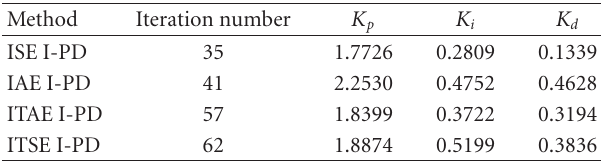
Figure 7: Final convergence of controller parameters with (a) ISE-, (b) IAE-, (c) ITAE-, and (d) ITSE-guided BFO algorithm. Table 1: Optimised controller